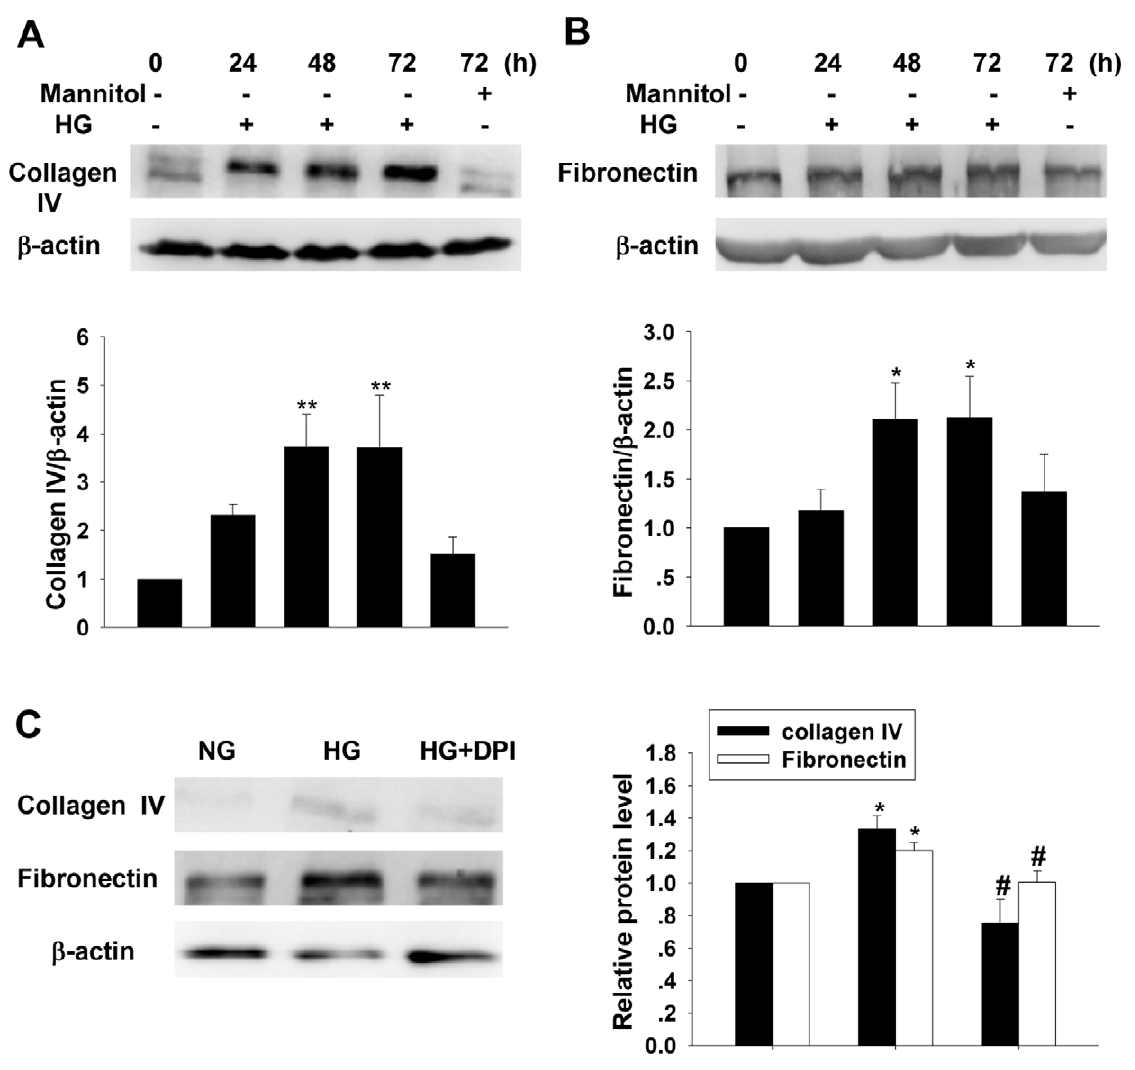
Figure 2. Effects of high glucose treatment on collagen IV and fibonectin. Western blot results show high glucose treatment increases collagen IV (A) and fibronectin (B) levels (mean 6 SEM, n=6). DPI reverses high glucose-induced increase in collagen IV and fibronectin expressions (C) (mean 6 SEM, n=5). * p , 0.05 compared to NG; *** p , 0.001 compared to NG. # p , 0.05 compared with HG.